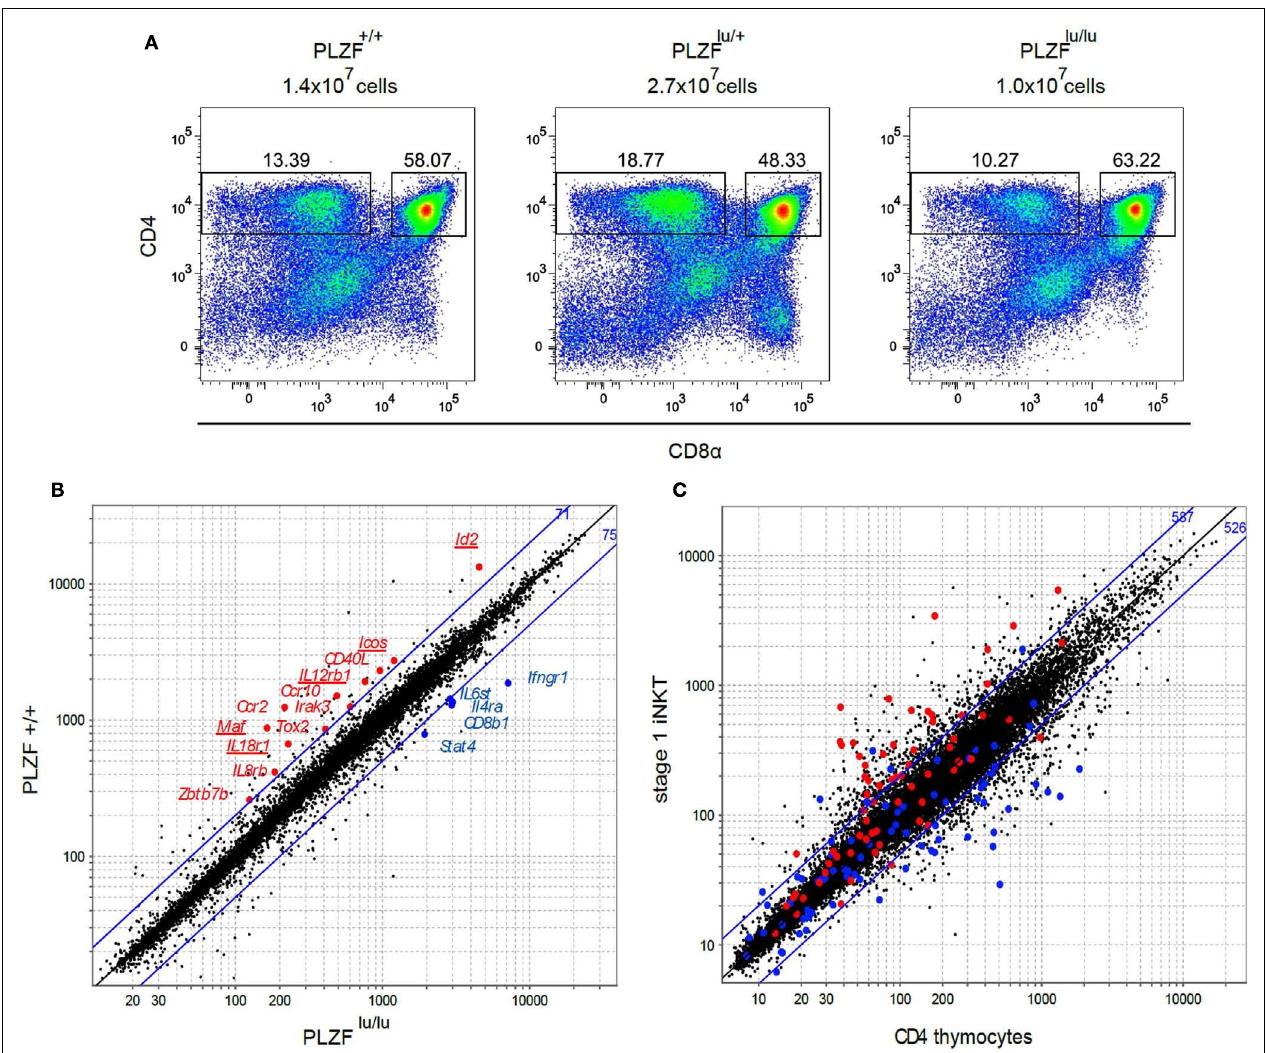
lines indicate twofold difference thresholds in expression between PLZF + / + and PLZF lu/lu thymocytes. Numbers in blue indicate the number of probe sets above the upper line and below the lower line. Some of the immunologically relevant genes are highlighted and labeled. (C ) Expression values of conventional CD4 thymocytes ( X axis) against stage 1 NKT cells ( Y axis) from Immgen database are plotted. Genes positively regulated by PLZF above the twofold threshold in ( B ) are highlighted in red, those regulated negatively – in blue. Blue lines indicate twofold difference thresholds in expression. Numbers in blue indicate the number of probe sets above the upper line and below the lower